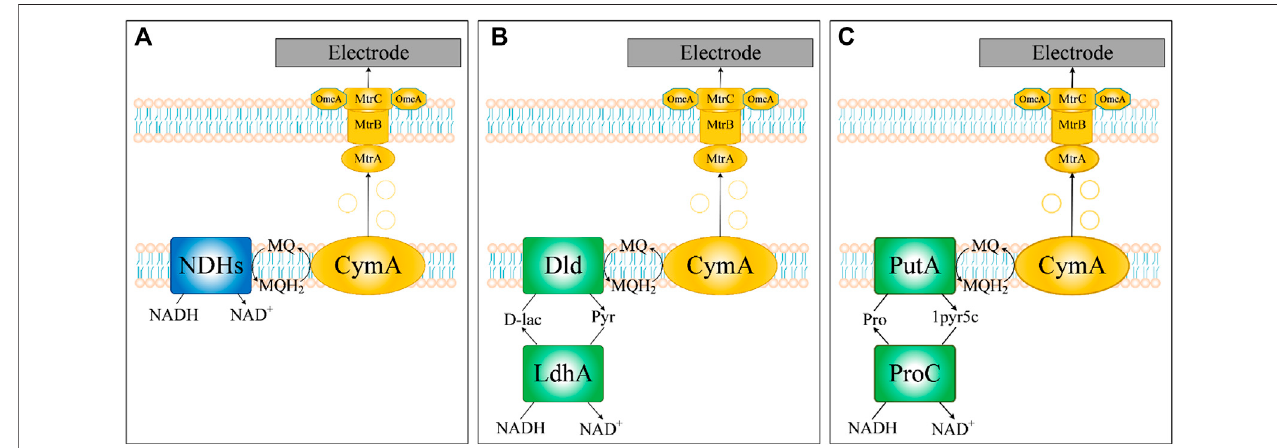
FIGURE 8 | Three NADH dehydrogenases predicted by iLJ1162 for electron transfer in S. oneidensis MR-1. (A) Electron transfer based on NADH dehydrogenases. (B) Electron transfer based on LdhA-Dld. (C) Electron transfer based on ProC-PutA.